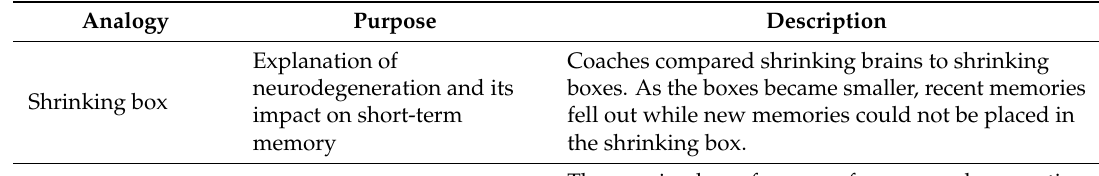
Table 2. List of Analogies and